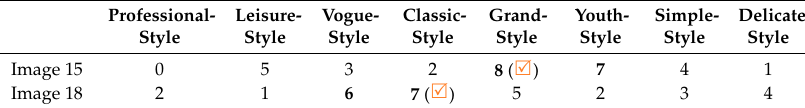
Figure 13. The evaluation results of samples 15 and 18. Table 5. The style evaluation results of images 15 and 18. Table 4. Image style evaluation results.